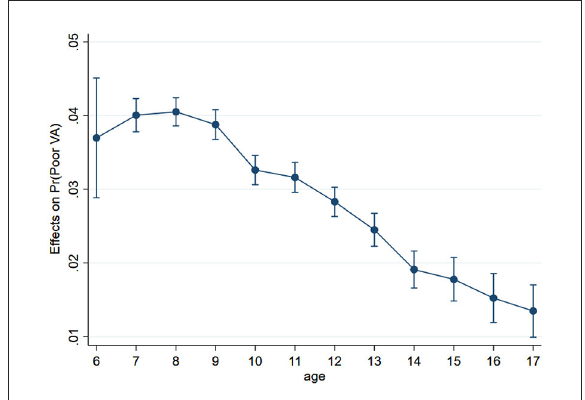
FIGURE2 The marginal effects of age and the use time of digital devices on the poor visual acuity among children and adolescents. The results adjusted by sex,